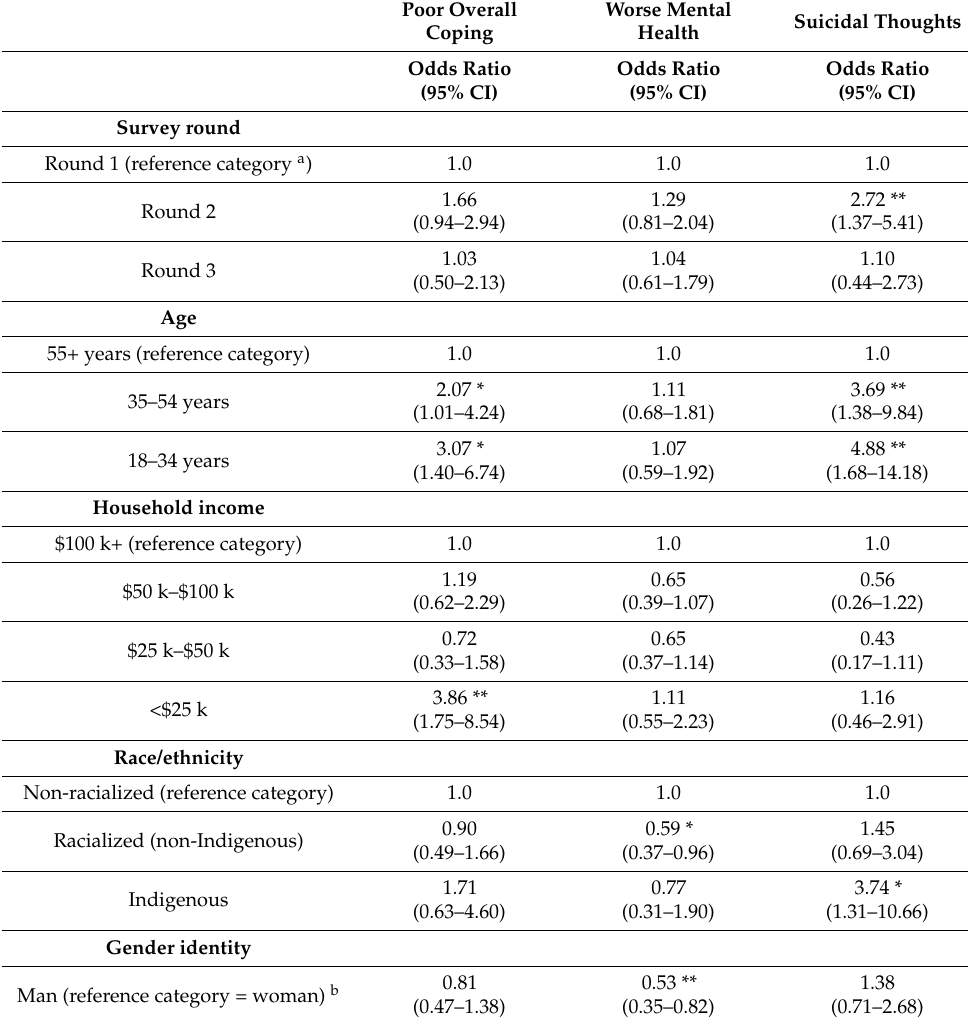
Table 3. Results of fully adjusted multivariable logistic regression models predicting poor overall coping, worse mental health, and suicidal thoughts among LGBTQ2+ respondents to a national Canadian repeated survey during the COVID-19 pandemic,